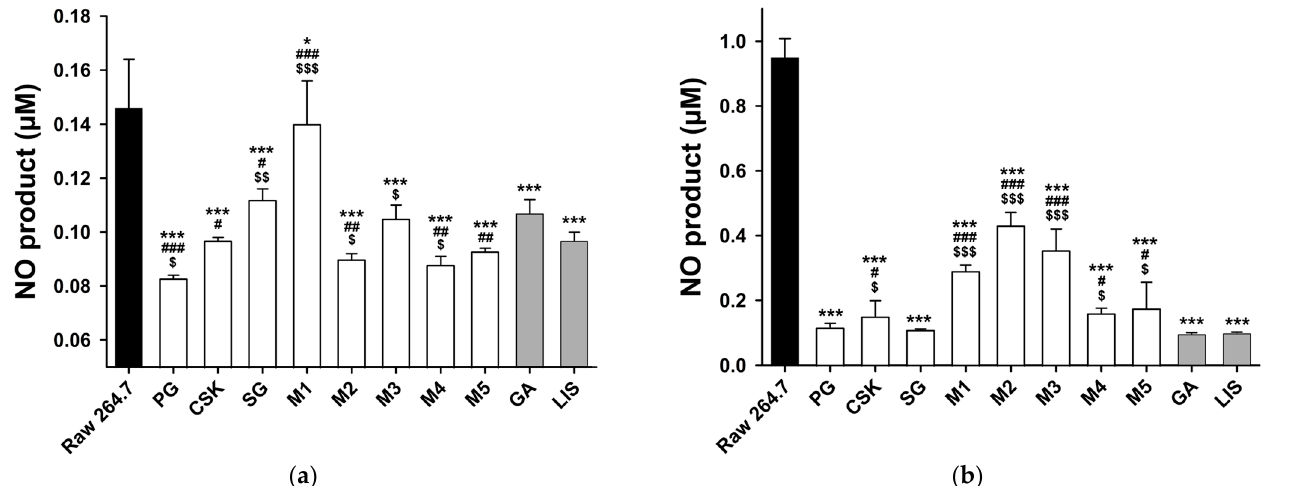
Figure 4. Nitric oxide (NO) assay ELISA statistical graph. ( a ) Non- lipopolysaccharide (LPS) treatment; ( b ) LPS treatment. All experimental groups were compared to the negative controls, GA and LIS, and the positive control RAW 264.7 cells. * vs Con. p < 0.5, ** vs Con. p < 0.01, *** vs Con. p < 0.001, # vs GA. p < 0.5, ## vs GA. p < 0.01, ### vs GA. p < 0.001, $ vs LIS. p < 0.5, $$ vs LIS. p < 0.01, $$$ vs LIS. p < 0.001.